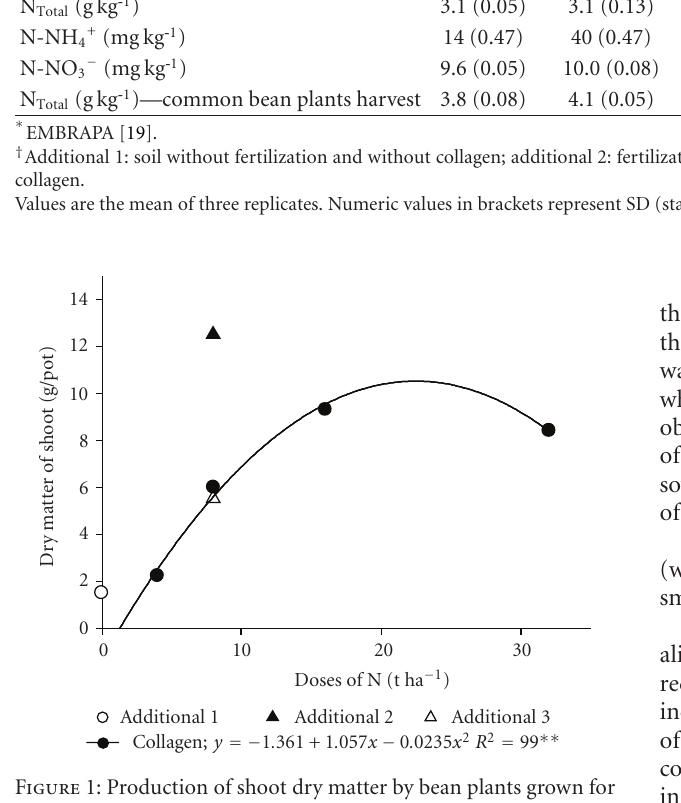
Figure 1: Production of shoot dry matter by bean plants grown for 84 days, under influence of the studied treatments (collagen – four rates; additional 1: soil without fertilization and without collagen; additional 2: fertilization with mineral N; additional 3: wet blue